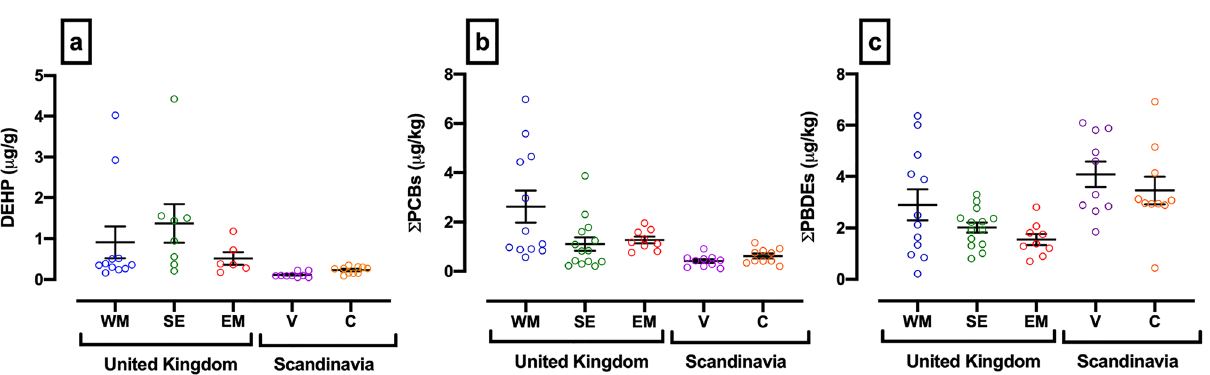
Figure 6. Mean testis concentrations of DEHP, ∑PCB congeners and ∑PBDE congeners across five national and international geographic boundaries: United Kingdom (West Midlands, South East and East Midlands), Finland (Vantaa) and Denmark (Copenhagen). DEHP ( a ), ∑PCBs ( b ; Mean concentrations of the sum of seven congeners of PCB) and ∑PBDEs ( c ; Mean concentrations of the sum of seven congeners of PBDE). Each point represents an individual testis from a specific geographical region: UK; West Midlands (WM: blue), South East (SE: green), East Midlands (EM: red) and Scandinavia; Vantaa, Finland (V: purple) and Copenhagen, Denmark (C: orange). Error bars and lines denote mean ± 1 S.E.M. Figures were created using GraphPad Prism version 8.0 for Mac, GraphPad Software, California, USA (https:// www. graph pad.